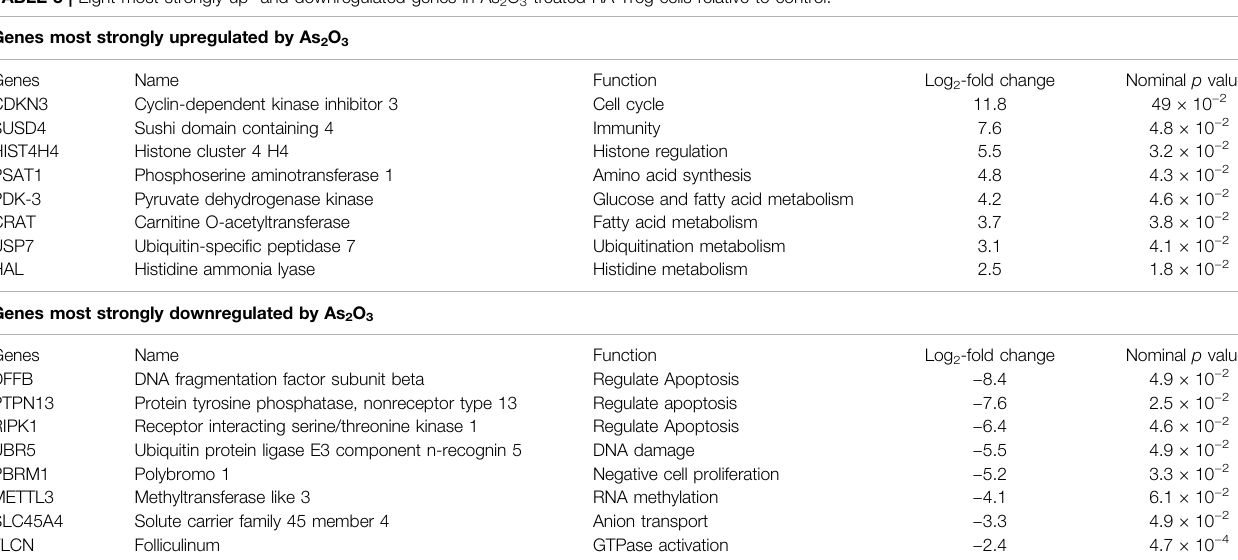
( Figure 7 ). In summary, the signi fi cantly overrepresented BPs, MFs, and CCs were dramatically different between nontreatment Treg and treatment Treg cell with As 2 O 3 .